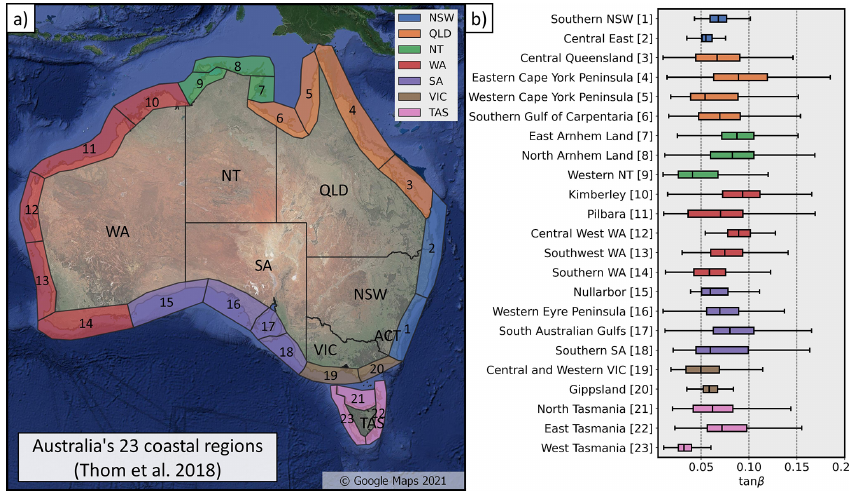
Figure 5. Distribution of beach-face slopes for each of the 23 coastal regions identified by Thom et al. (2018).